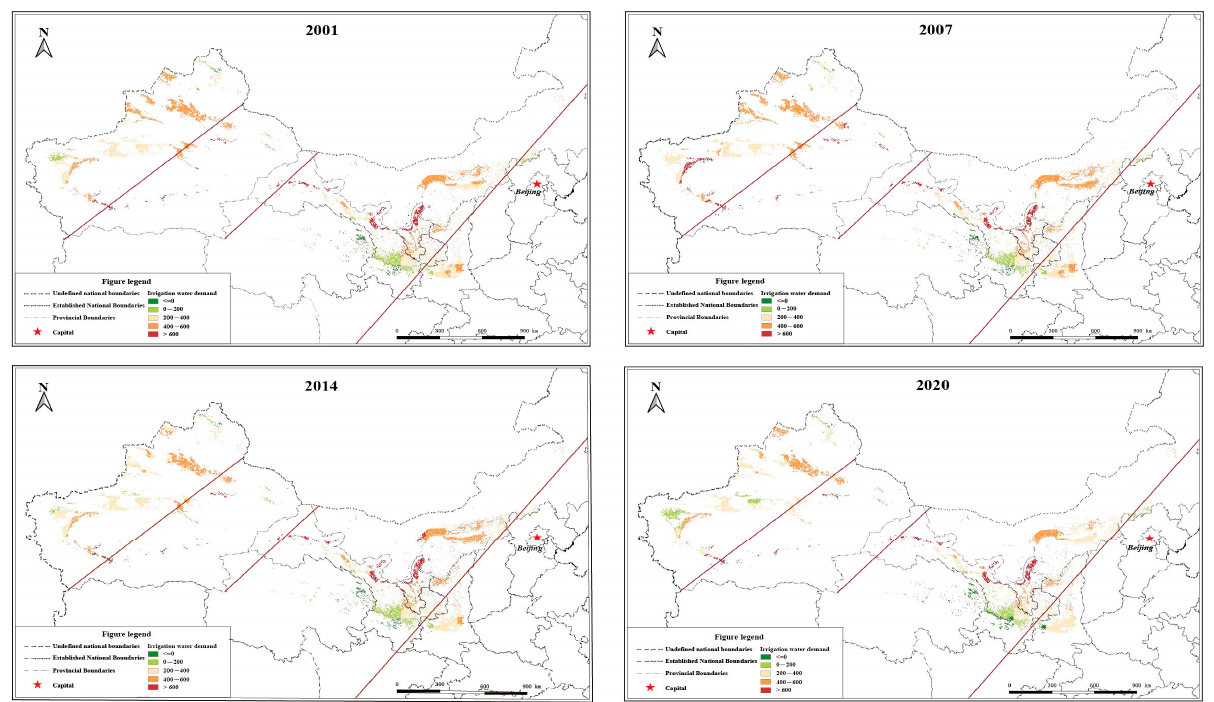
Figure 4. Spatial distribution of IWR in northwest ‘Three Water Lines’ area. 3.2.2. Characteristics of the IWR in Sub-Regions of the ‘Three Water Lines’ Area Statistics on the IWR in the northwest ‘Three Water Lines’ region from 2001 to 2020 are shown in Table 3. Moreover, the trend of meteorological changes in the northwest ‘Three Water Lines’ region from 2001 to 2020 is shown in Figure 5. The above data are used to analyze the various characteristics of the IWR in the northwest ‘Three Water Lines’ area. Table 3. IWR in sub-regions of ‘Three Water Lines’ area from 2001 to 2020.